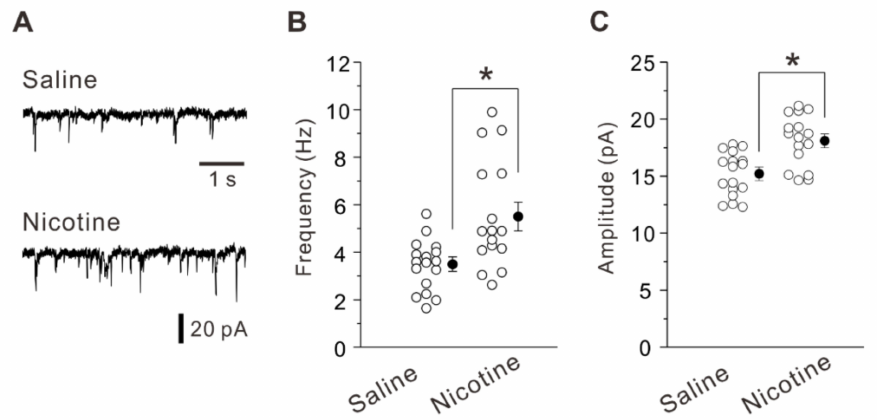
Figure 1. Enhanced excitatory synaptic transmission caused by adolescent nicotine exposure. ( A ) Sam- ple traces of sEPSCs obtained from layer V PNs of a saline-treated mouse (top) and a nicotine-treated mouse (bottom). ( B , C ) Summary data of frequency ( B ) and amplitude ( C ) of sEPSCs obtained from PNs of saline-treated mice (n = 17 neurons/6 mice) and nicotine-treated mice (n = 16 neurons/7 mice). Unpaired t -test, *: p < 0.003.